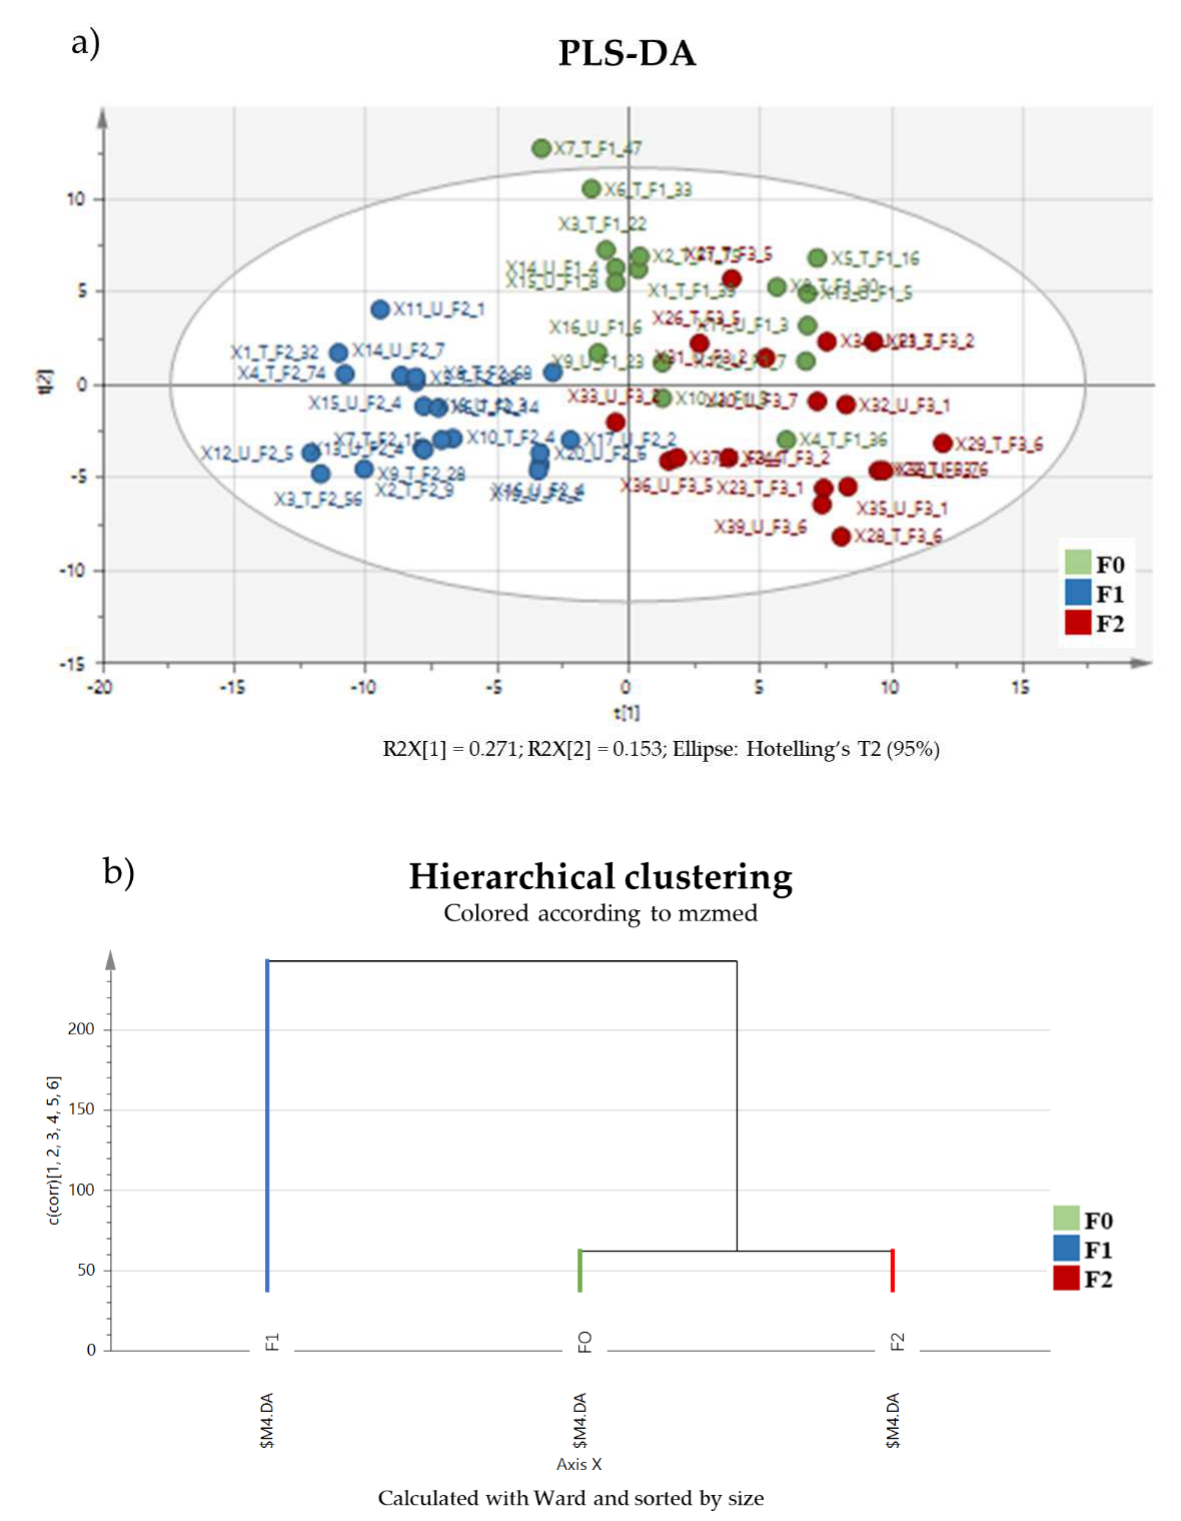
Figure 3. ( a ) PLS-DA model calculated using spermatozoa samples (control and NU-exposed) collected from all generations. The PLS-DA showed significant separation between the metabolomic profiles of each generation (CV-ANOVA; p = 2.19 × 10 −27 ; R2Y = 96.3; Q2Y = 88.5) ( b ) Hierarchical clustering shows more similarity between generations F0 and F2 than between F0 and F1.